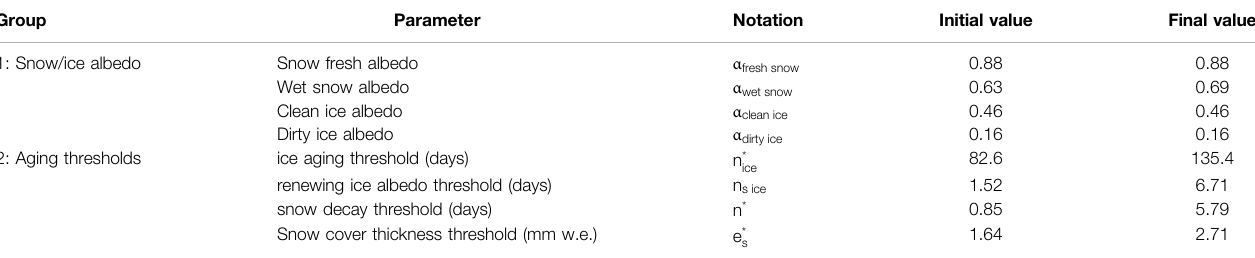
TABLE 2 | Albedo parameters after calibration completed. The initial snow/ice albedos (initial value) and aging threshold values ( fi nal value) were taken from Gurgiser et al., 2013a and Maisincho (2015), respectively.